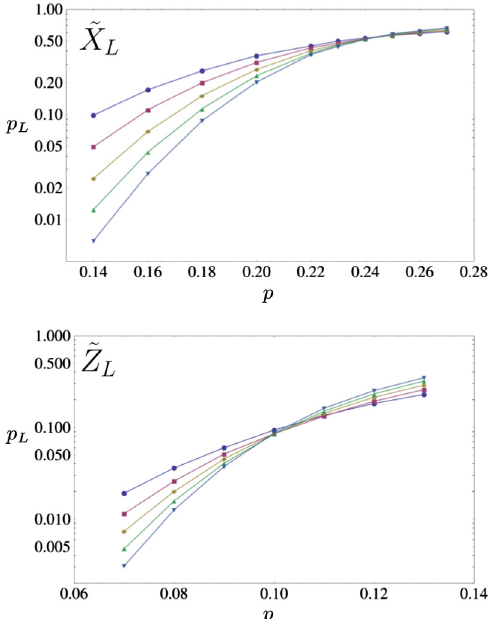
~ X ~ Z of the logical operators and L L L ≈ 24% for ~ X ≈ 10% and p c L c